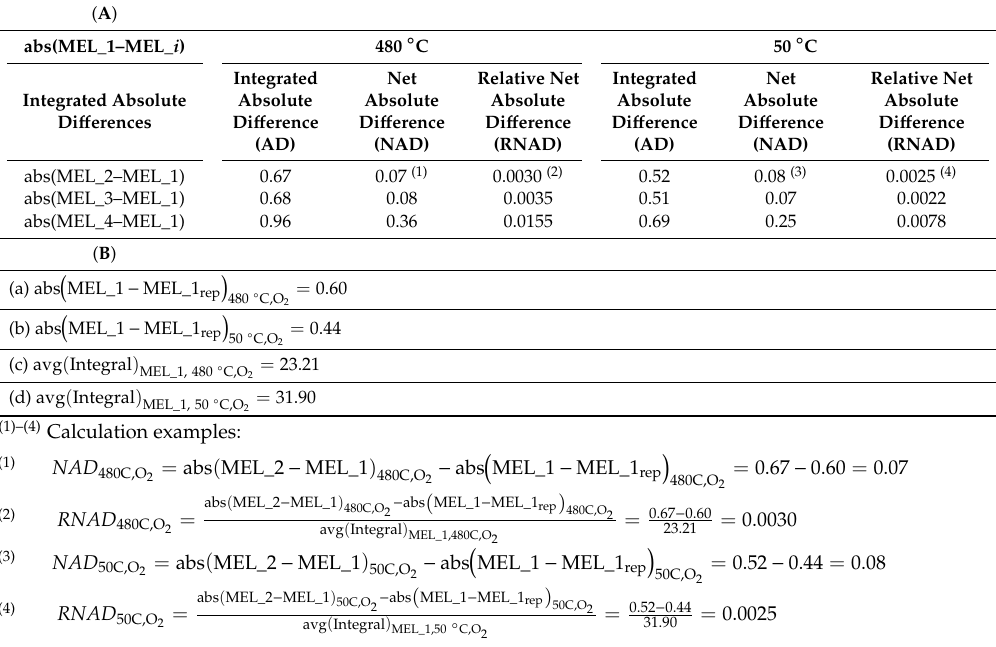
di ff erence (NAD) and relative net absolute di ff erence (RNAD) are listed in Table 1. Table 1. ( A ) Integrated absolute di ff erences (AD), net absolute di ff erences (NAD), and relative net absolute di ff erences (RNAD) amongst the commercial rare earth doped Ce x Zr 1- x O 2- δ -based MEL_ i ( i = 1–4) solid materials based on their respective in situ Raman spectra obtained under 20% O 2 / He gas atmosphere at temperatures of 480 and 50 ◦ C. Reference experimental data pertaining to sample MEL_1 were used for calculating the NAD and RNAD (see Section 3.2.4). ( B ) Reference experimental data pertaining to sample MEL_1 used for calculating the NAD and RNAD (see Section